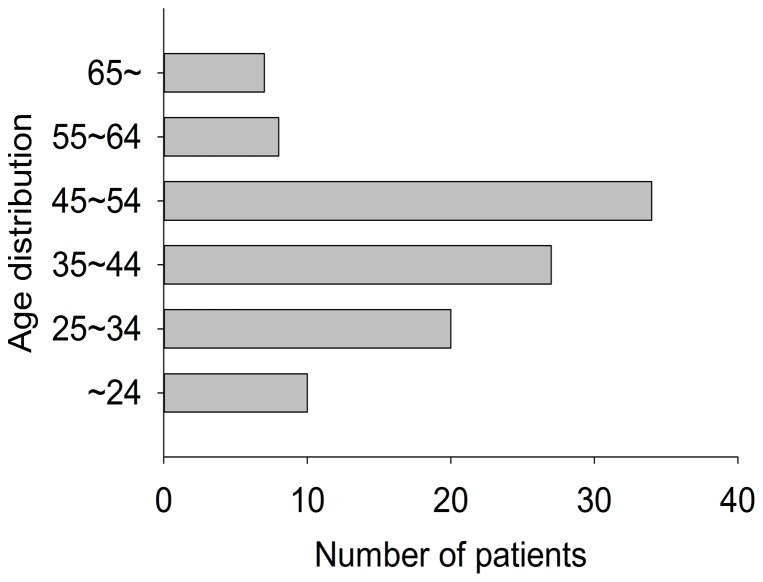
Age distribution of total patients.